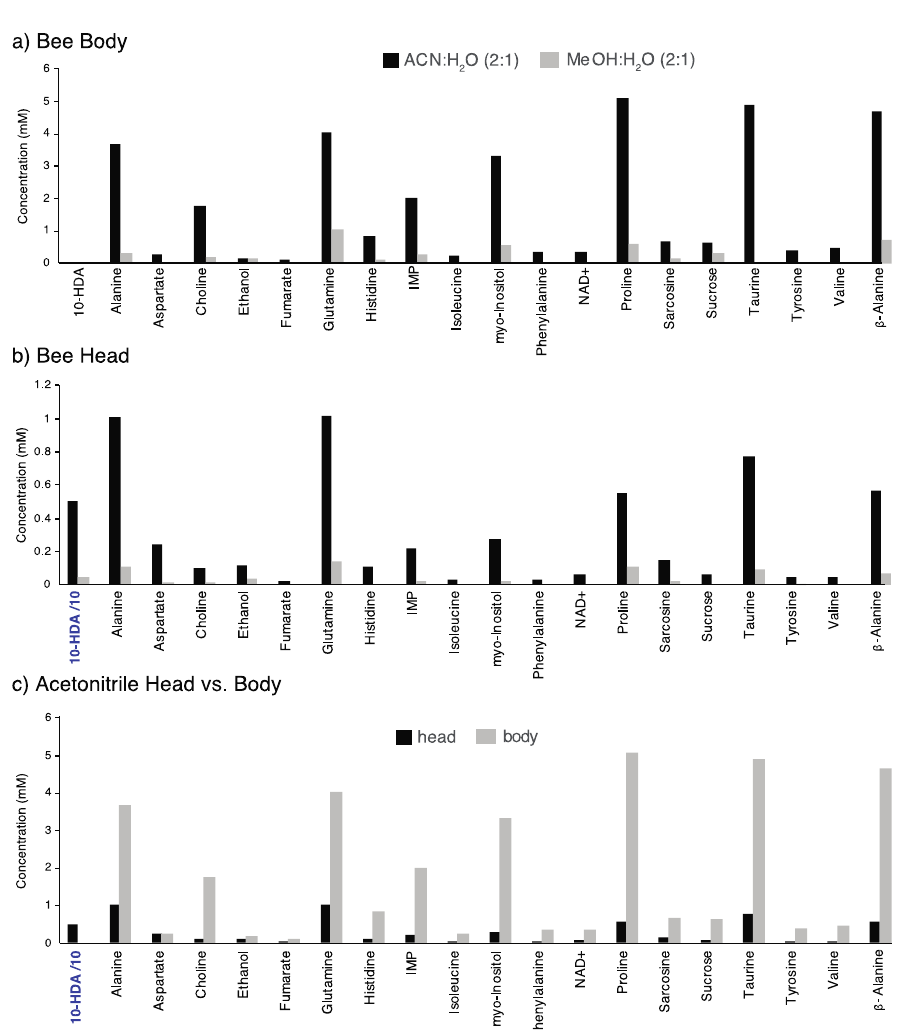
Figure 3. Representative metabolites recovered from head and body samples are shown. Results contrasting methanol:water (2:1) to acetonitrile:water (2:1) show better metabolite recovery from the acetonitrile treatment in both (a) bee bodies and (b) bee heads. In (c) the greater metabolite recovery